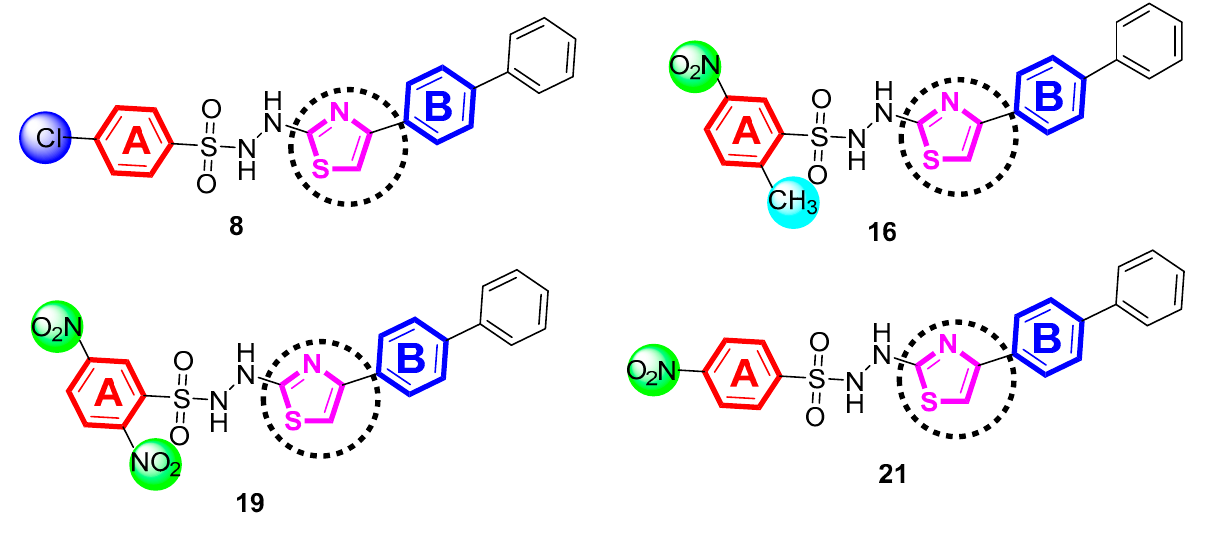
Figure 6. SAR study for scaffolds 8 , 16 , 19, and 21 .